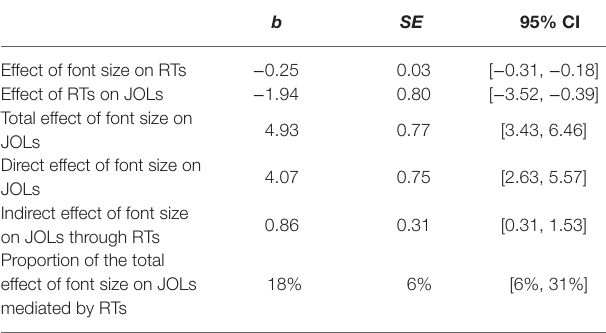
TABLE 3 | Multilevel mediation analysis results in Experiment